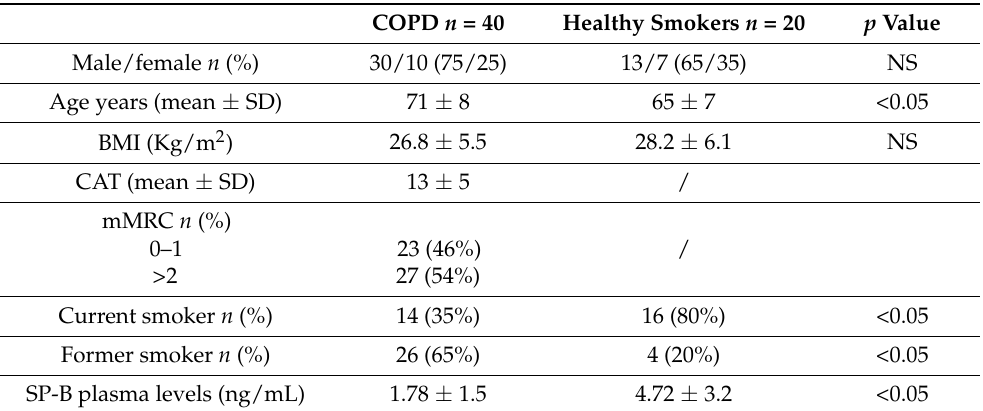
Table 1. Demographic and clinical characteristics of the study population.